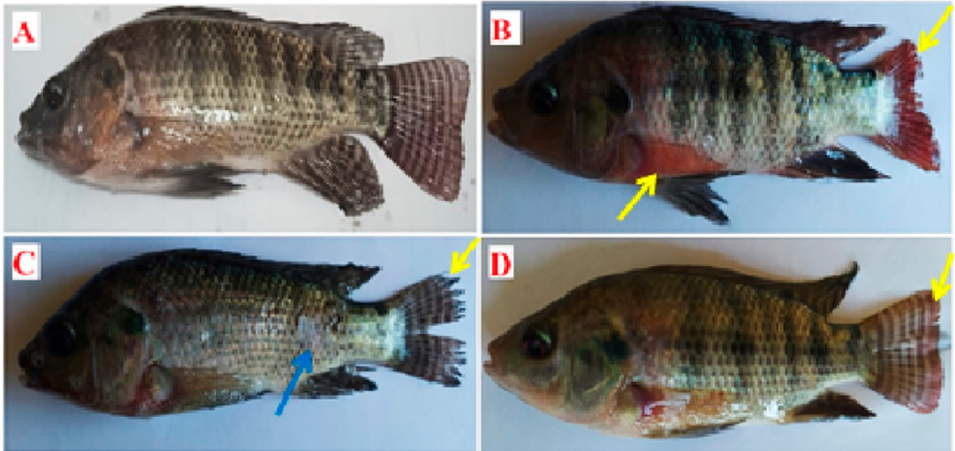
Figure 2. Effect of CWPNC as water exposure on clinical observation of experimentally infected O. niloticus with S. agalactiae for 7 days. ( A ) Fish in the control group or CWPNC group demonstrated normal appearance. ( B , C ) Fish in the S. agalactiae group showed skin ulcers (blue arrows), hemorrhagic patches on the body, and fin rot (yellow arrows). ( D ) Fish in the CWPNC + S. agalactiae group showed some fin rot (yellow arrow).